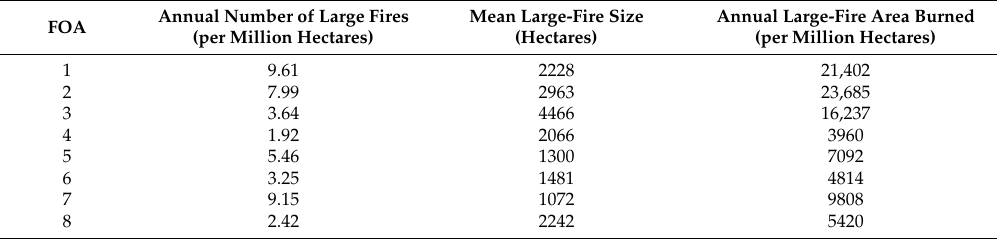
Table 6. Large-fire simulation results summarized by fire occurrence areas (FOA).